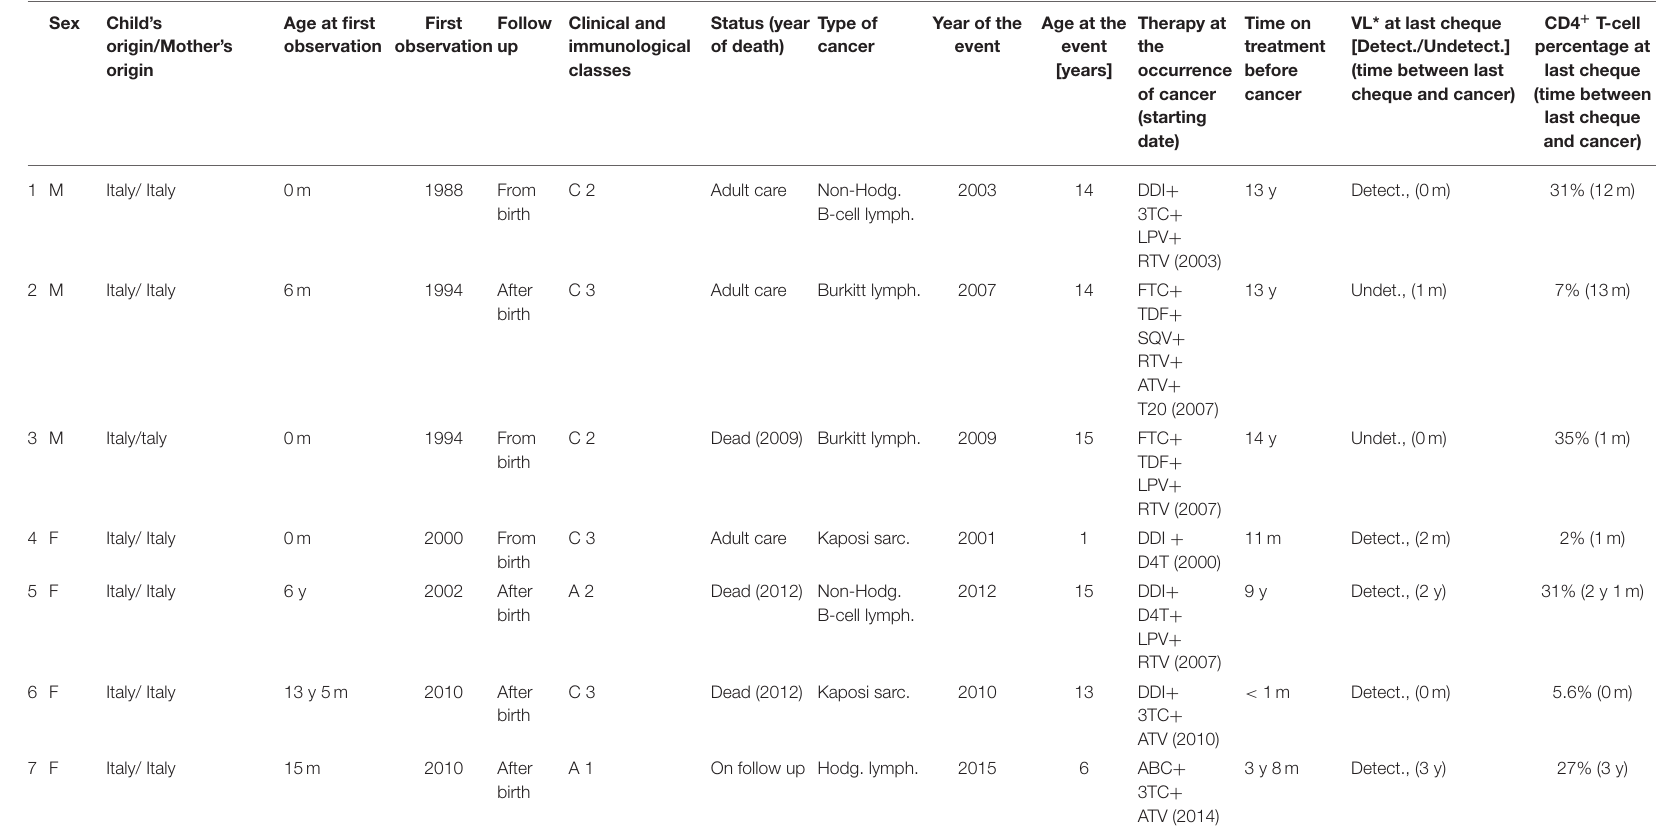
TABLE 8 | Characteristics of malignancies occurred in the study population from 2001 to 2018.